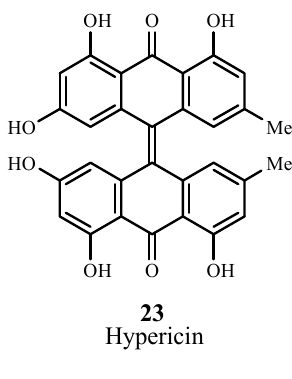
Figure 16. Example of an anthraquinone PDT sensitizer.